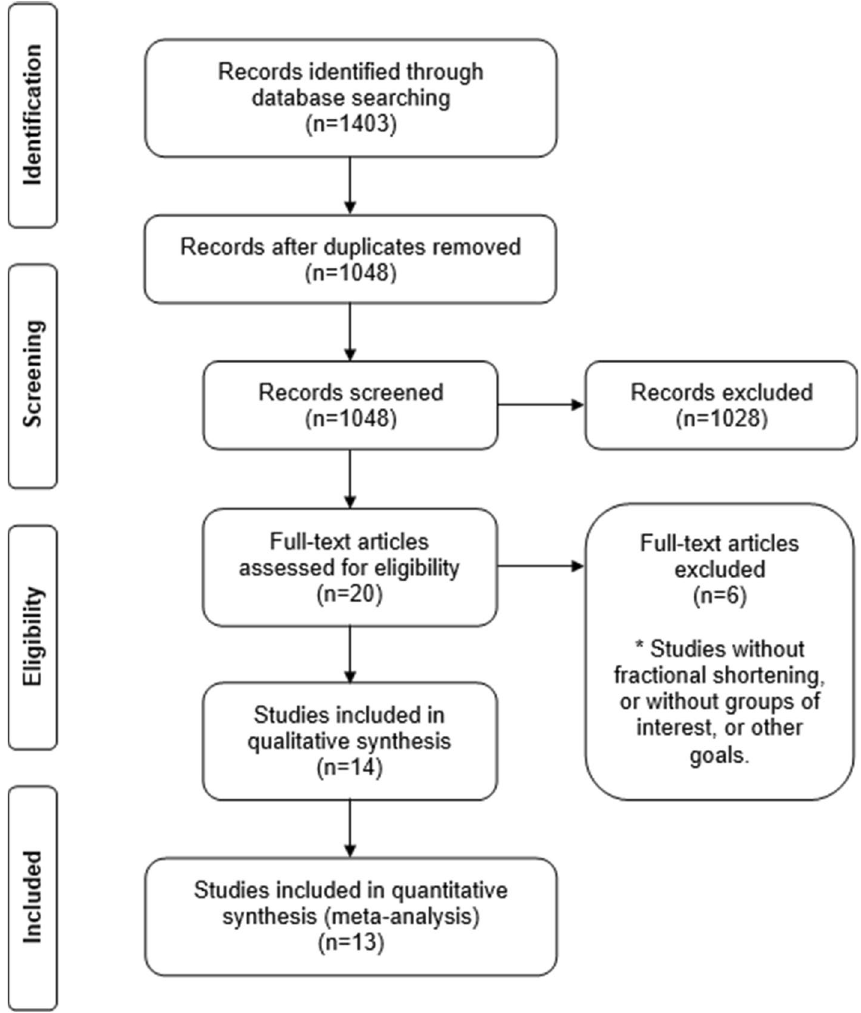
Figure 1. Flow chart of the study selection